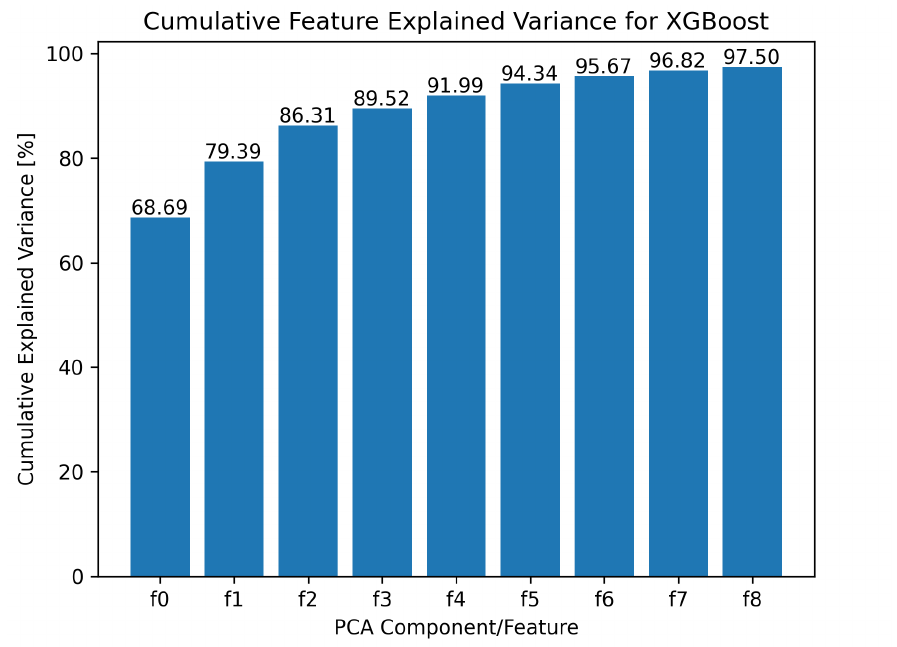
Figure 5. Cumulative Feature explained variance for